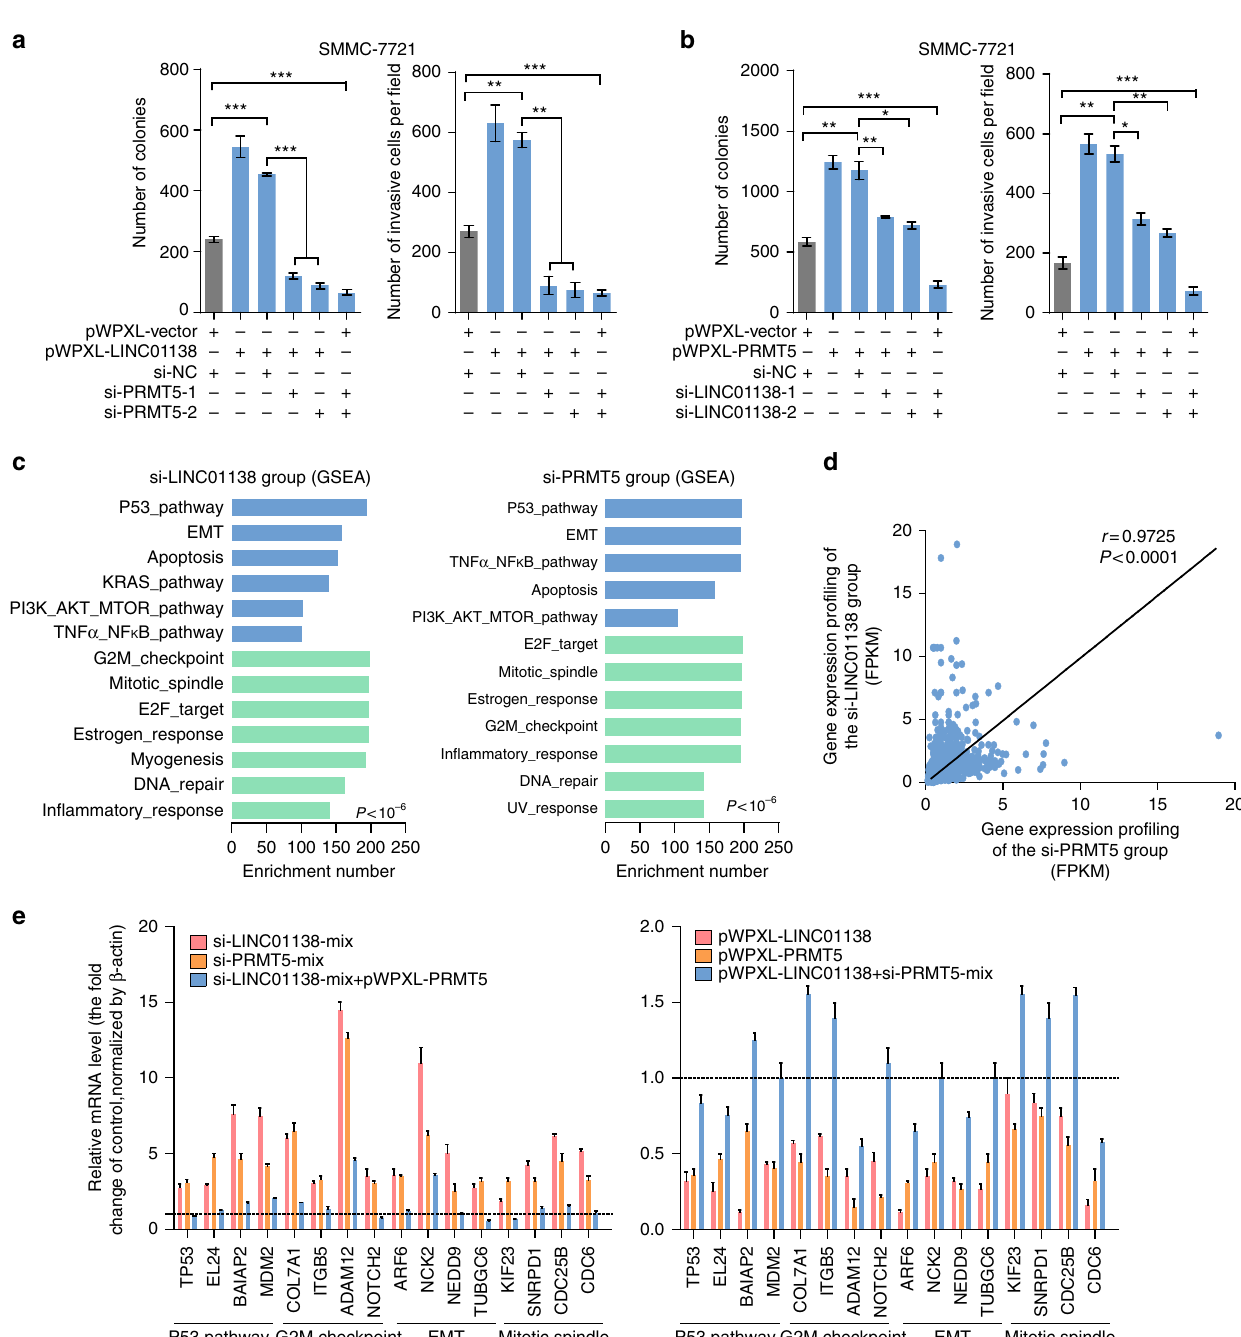
Fig. 5 PRMT5 mediates LINC01138-driven HCC cell growth, migration and invasion. a Rescue assays of colony formation assay were performed after silencing PRMT5 in pWPXL-LINC01138 cells. b Rescue assays of transwell invasion assay were performed after silencing PRMT5 in pWPXL-LINC01138 cells. c GSEA enrichment focused on a set of signalling pathways and biological processes after LINC01138 silencing and PRMT5 silencing, summarized based on the enrichment score (signalling pathway, blue; biological process, green). d Correlation analysis of the gene expression pro fi ling between the si- LINC01138 group and si-PRMT5 group. e The mRNA levels of tumorigenesis-related genes in the high-scored four signalling pathways in cells with indicated treatments. Values are expressed as the mean ± SEM, n = 3 in a , b , d , e . ** P < 0.01 and *** P <